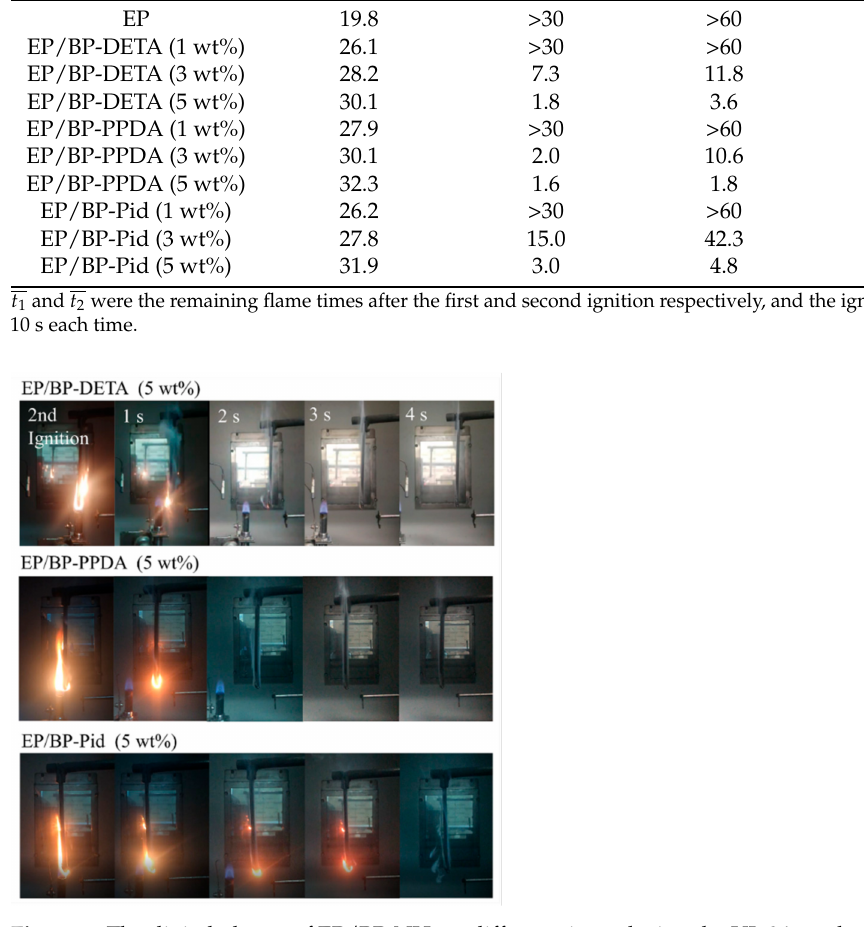
Figure 6. The digital photos of EP/BP-NH 2 at different times during the UL 94 combustion